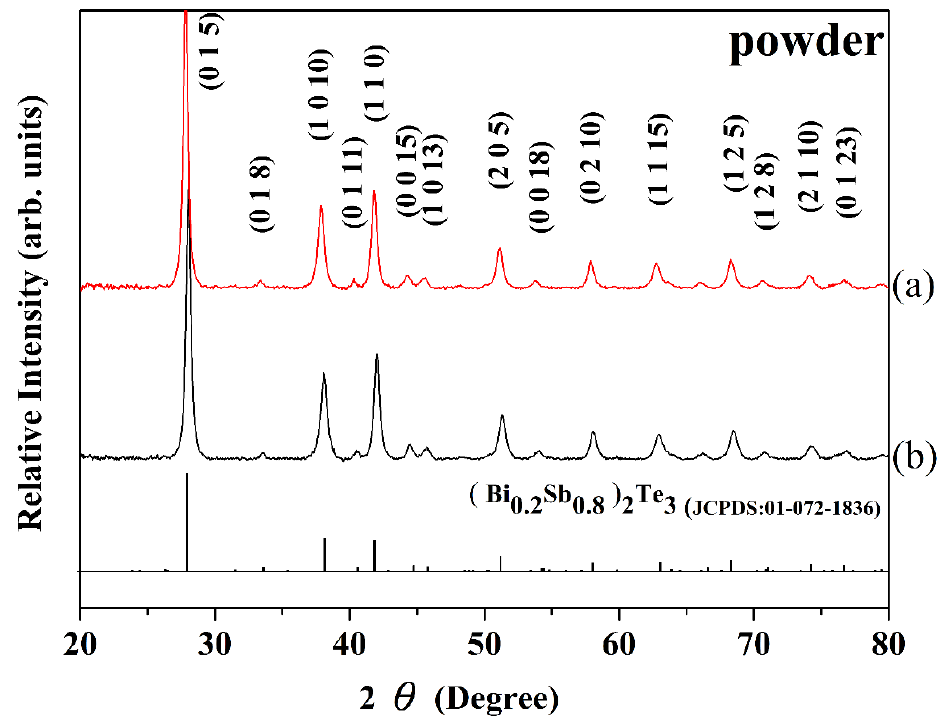
Figure 1. XRD patterns of as-milled Bi 0.4 Sb 1.6 Te 3 and γ -Al 2 O 3 -doped Bi 0.4 Sb 1.6 Te 3 powders. ( a ) 1 wt % Al 2 O 3 ; ( b ) 3 wt % Al 2 O 3 . ( a ) 1 wt % Al 2 O3; ( b ) 3 wt % Al 2 O 3 .